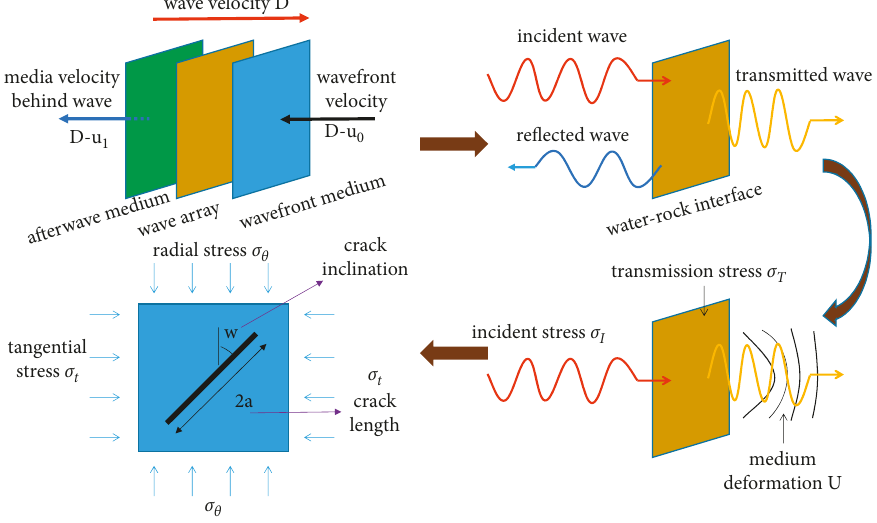
Figure 6: Process of hydraulic blasting